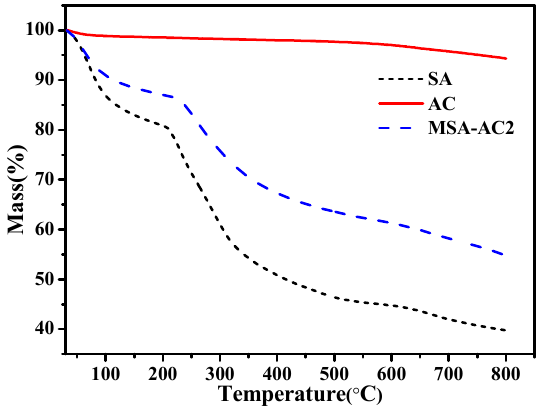
Figure 4. TGA curves of SA, AC and MSA-AC2.